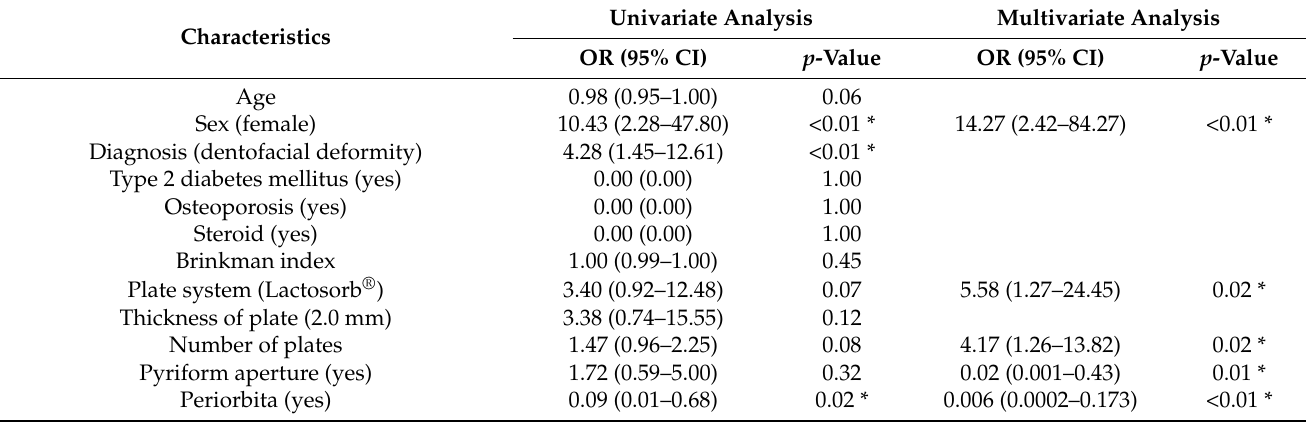
Table 3. Multivariate logistic regression analysis and propensity score-adjusted model (stabilized inverse probability of treatment weighting (IPTW)) to identify factors influencing the complication rate ( n =